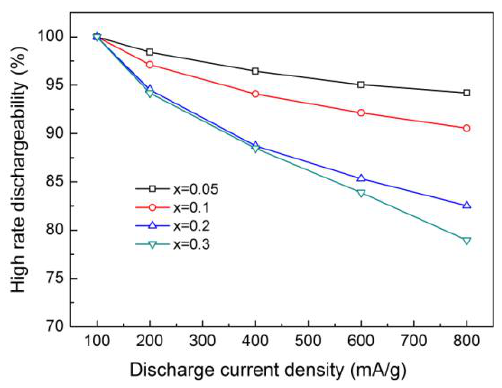
Figure 5. High-rate dischargeability ( HRD ) of La